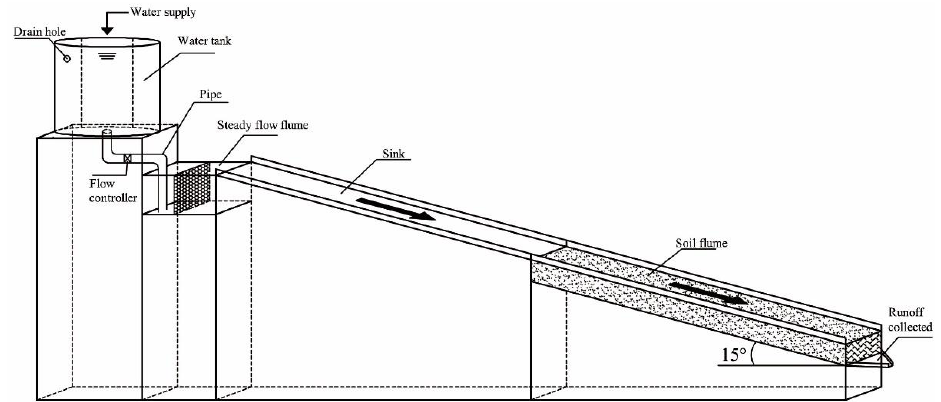
Figure 1. Schematic diagram of the simulated concentrated flow system.